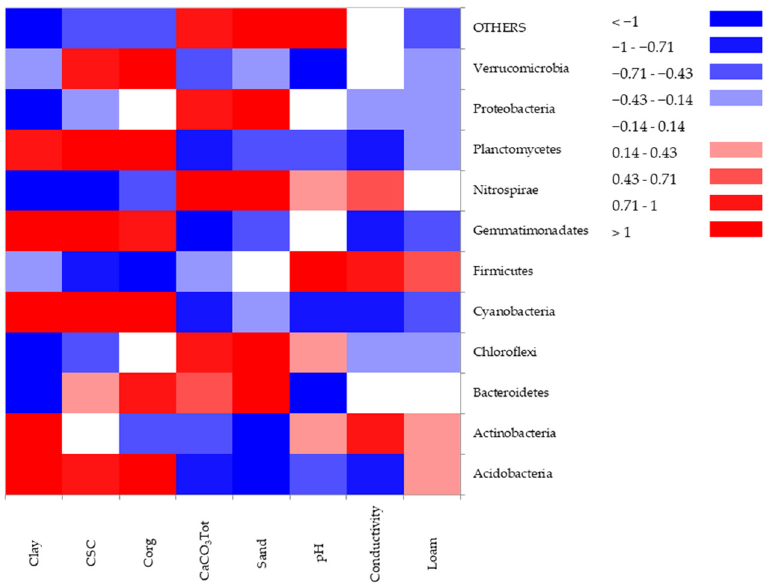
Figure 7. Pearson’s correlation between bacterial phyla and physicochemical characteristics of soil samples. Colour intensity indicates the level of association. Abbreviations are as follows: CaCO 3 Tot; total content of carbonate; EC, electrical conductivity; CEC, cation exchange capability; C org , content of organic